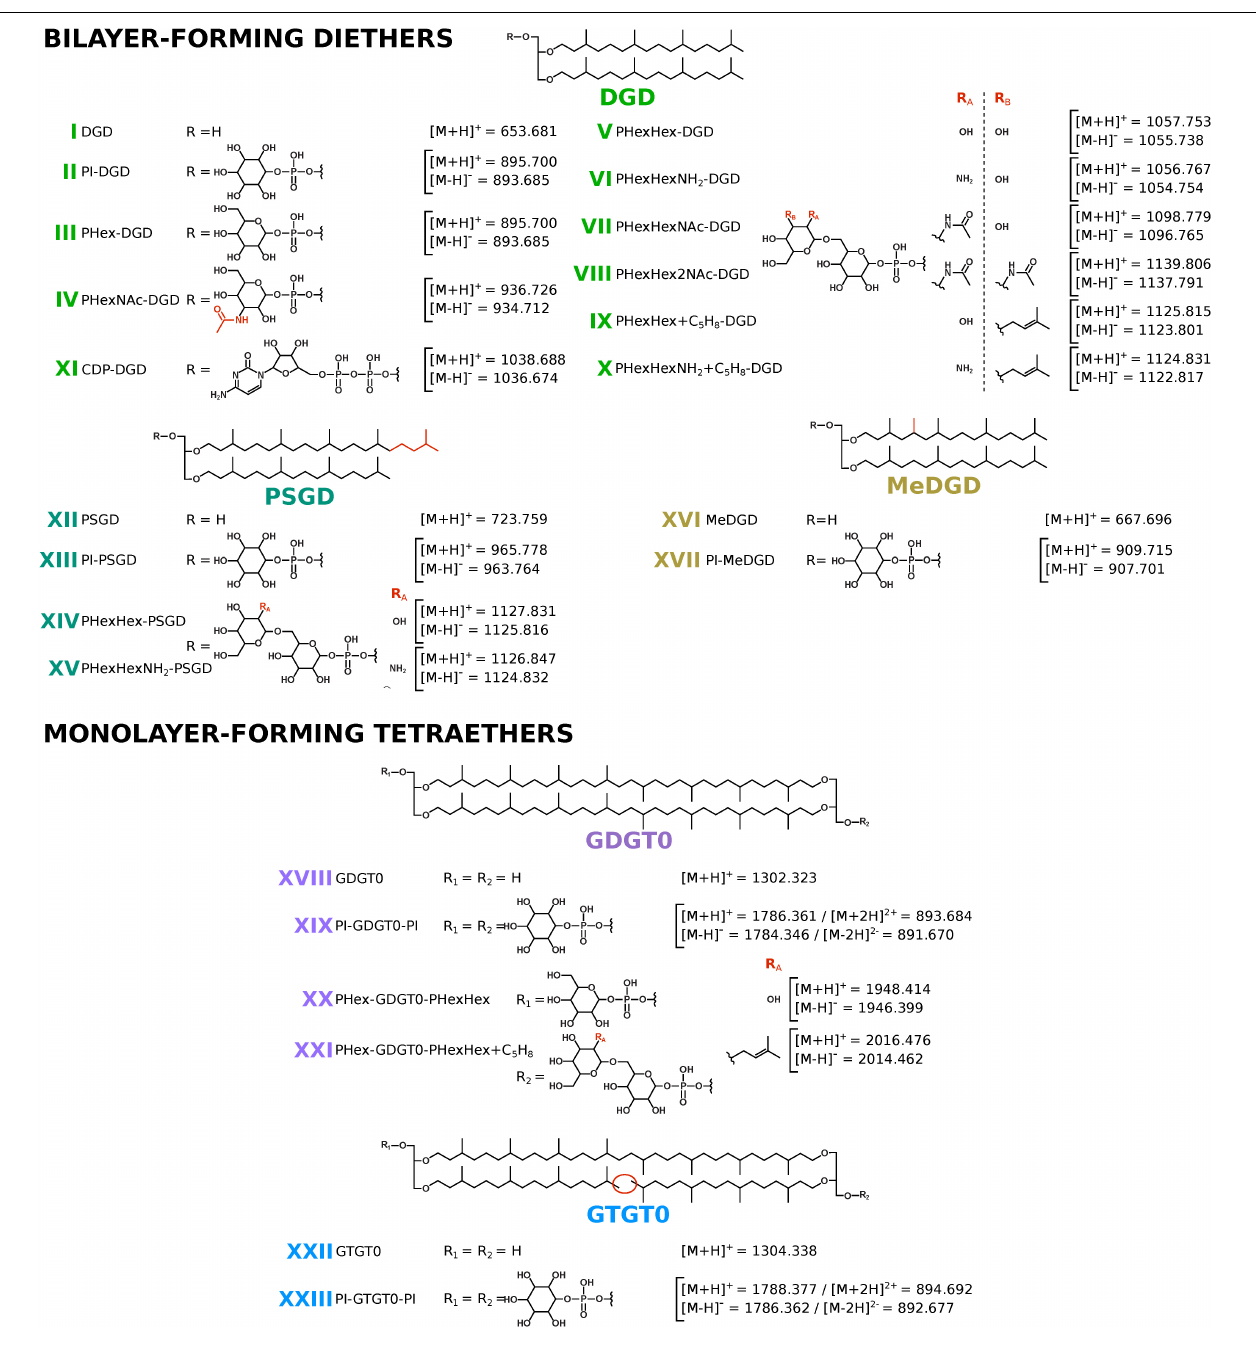
FIGURE 1 | Core and intact polar lipids of Thermococcus barophilus . Short-hand nomenclature is indicated. The protonated, ammoniated, and sodiated adducts and only the deprotonated adducts were detected in positive and negative ion modes, respectively. Only the protonated and deprotonated ions are represented in the figure. Core structures: diphytanyl glycerol diethers (DGD; light green; I to XI), phytanylsesterterpanyl glycerol diethers (PSGD; dark green; XII to XV), DGD bearing an additional methylation (MeDGD; yellow; XVI and XVII), glycerol dibiphytanyl (or dialkyl) glycerol tetraethers with no cyclopentane ring (GDGT0; purple; XVIII to XXI), and glycerol biphytanyl diphytanyl (or trialkyl) glycerol tetraethers with no cyclopentane ring (GTGT0; blue; XXII and XXIII). Note that II, III, IV, VI, and XI were detected with up to 8 unsaturations, whereas V, VII, IX, and X were detected with up to 6 unsaturations. No unsaturation was detected in the other core structures. Unsaturations are not represented. Polar head groups: phosphatidylinositol (PI; II, XIII, XVII, XIX, and XXIII), phosphatidylhexose (PHex; III, XX, and XXI), phosphatidyl-N-acetylhexosamine (PHexNAc; IV), glycosylated phosphatidylhexose (PHexHex; V, XIV, and XX), ammoniated PHexHex (PHexHexNH 2 ; VI and XV), one and two N-acetylated PHexHex (PHexHexNAc and PHexHex2NAc; VII and VIII), PHexHex and PHexHexNH 2 bearing an additional mass of 68 (PHexHex + C 5 H 8 and PHexHexNH 2 + C 5 H 8 ; IX and XXI, and X), and cytidine diphosphate (CDP; XI). Positions of additional methylation and of additional groups on the polar head groups are drawn arbitrarily in the